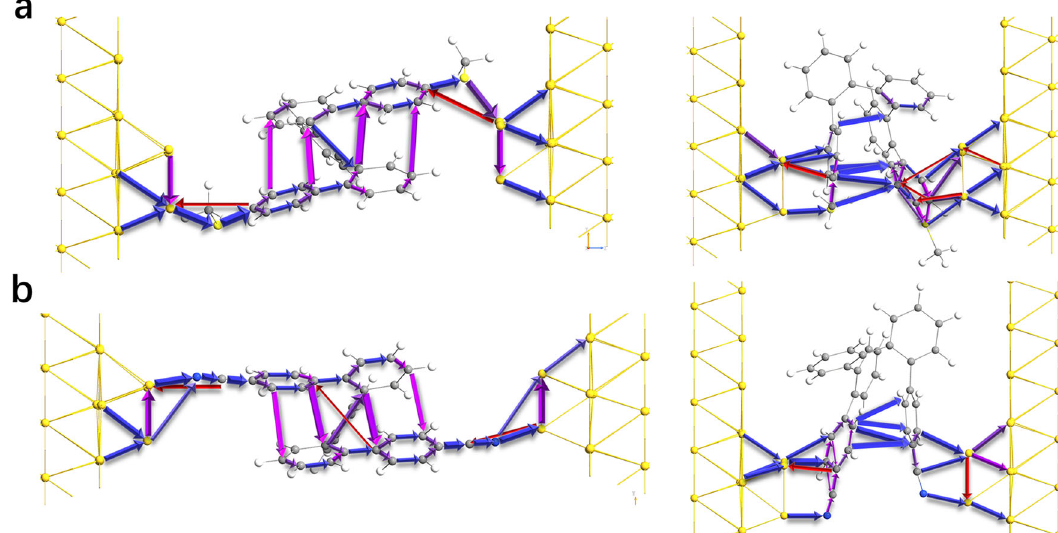
Fig. 7 Transmission pathways of o -PP derivatives in different conformers. a Transmission pathways for the AA and AB conformers of o -PP-2SMe. b Transmission pathways for the AA and AB conformers of o -PP-2CN. The blue arrows represent charge transport from the source electrode to the drain electrode, and the red ones represent the transport in the opposite direction; the larger size of arrows also indicates the higher possibility of charge